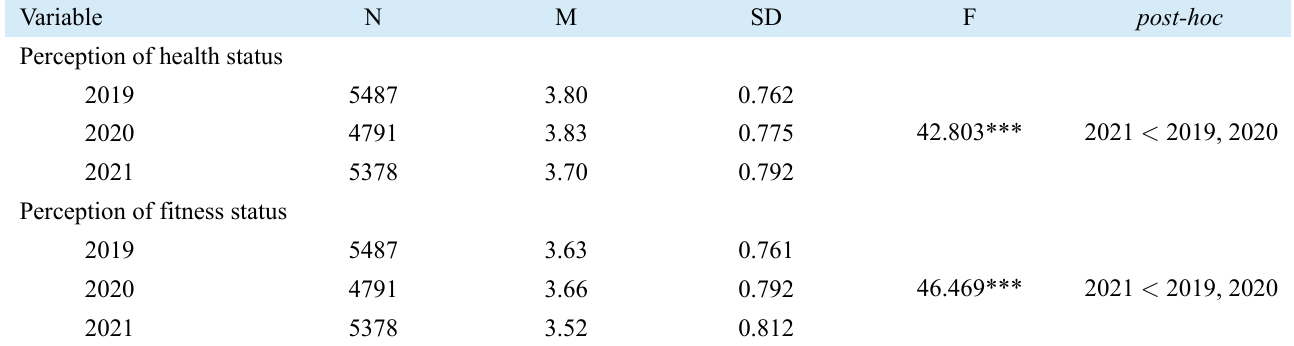
TABLE 4. Changes in the perception of health and fitness status by year (2019–2021).